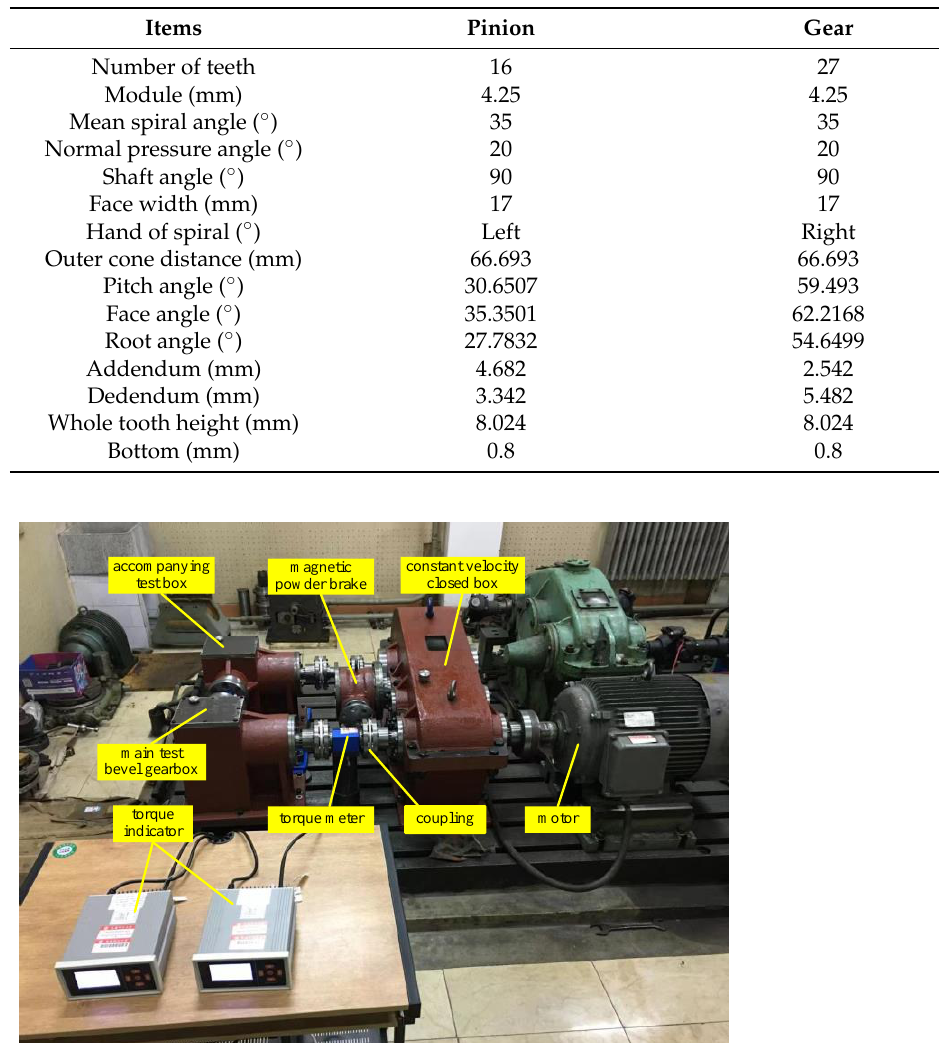
Table 1. Geometric parameters of the testing spiral bevel gears.